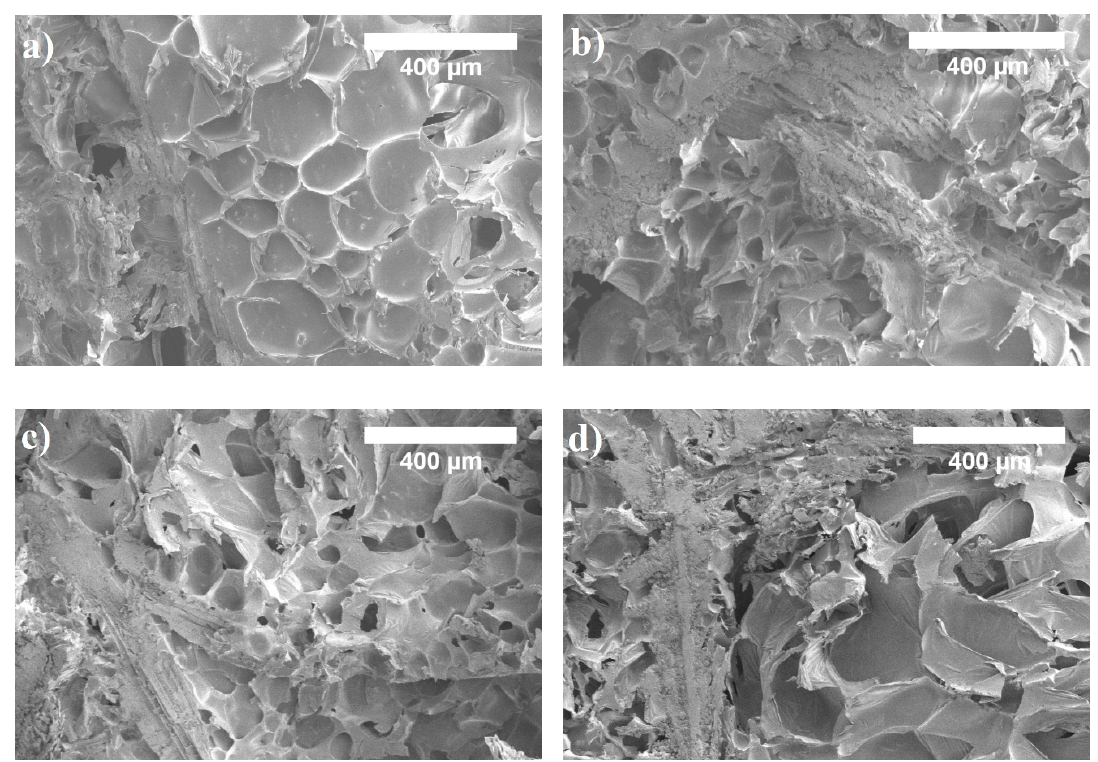
Figure 6. Microstructure of PUR biocomposite foams with different PURb/WS ratios: ( a ) 0.40 PURb/WS, ( b ) 0.55 PURb/WS, ( c ) 0.70 PURb/WS and ( d ) 0.85 PURb/WS (magnification ×150).